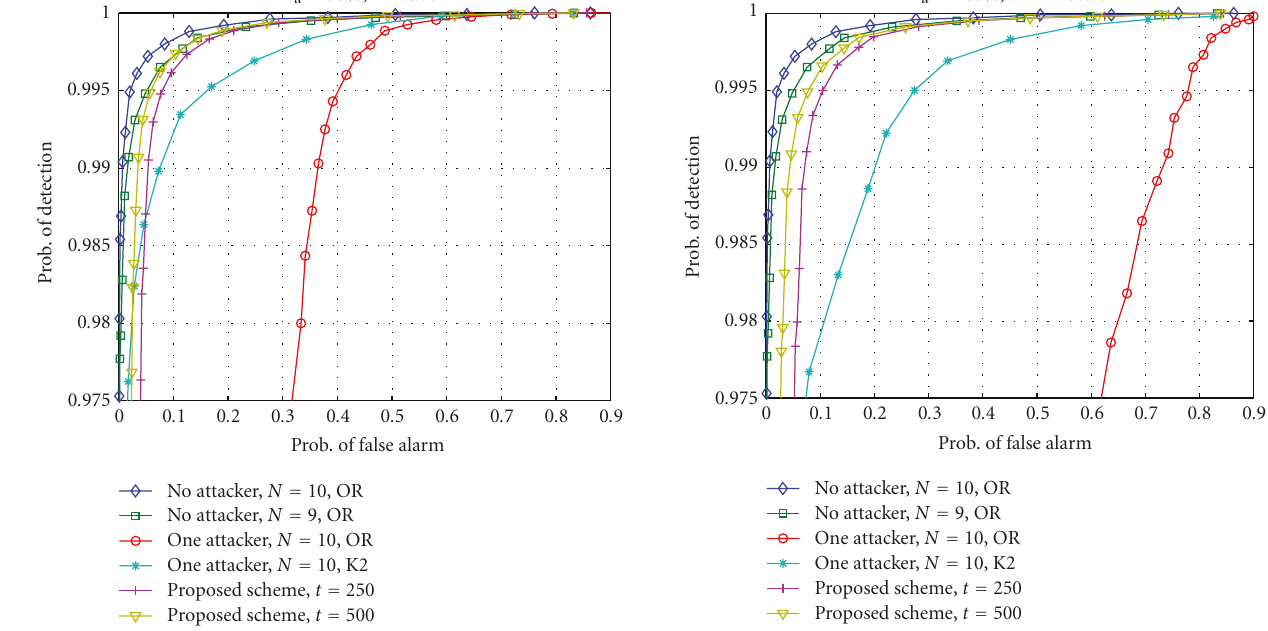
Figure 3: ROC curves for di ff erent collaborative sensing schemes ( P a = 50%, False Alarm Attack).